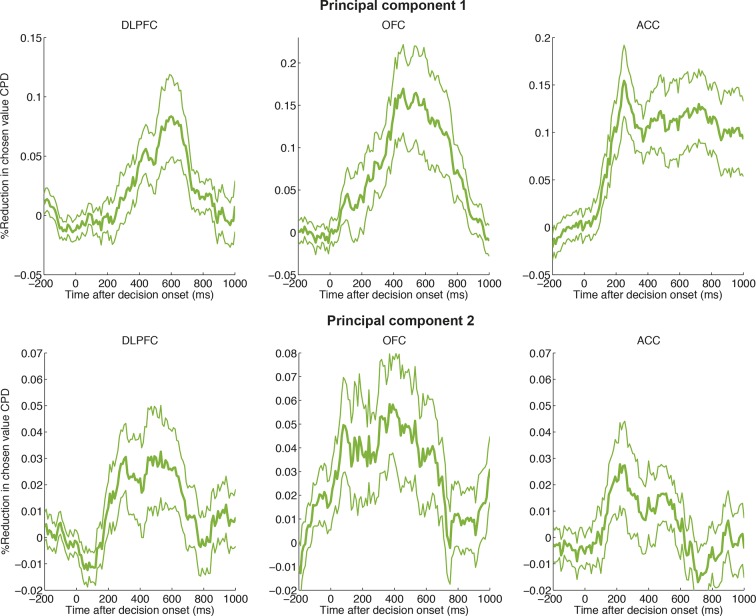
CPD for chosen value is reduced by including PC1/PC2 alone as coregressors.Whilst the main figure shows the reduction in chosen value by the inclusion of both PC1 and PC2 as coregressors in the regression model, this figure shows the independent influence of adding/removing PC1 and PC2 alone on the coefficient of partial determination (CPD) for chosen value in neurons across all areas. Across all three regions, PC1 reduces chosen value CPD to a greater extent than PC2. This is particularly the case in ACC, where PC1 showed a different relationship to chosen value than in DLPFC/OFC (see Figure 2—figure supplement 5). Lines show mean /- s.e. across neurons.